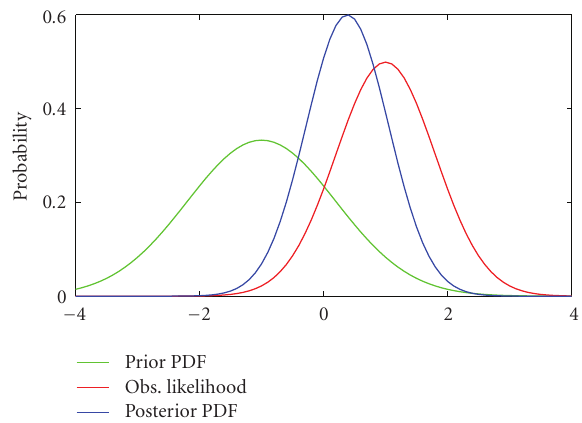
Figure 3: The observations (red curve), prior (green curve), and posterior (blue curve) probability density function given Gaussian error